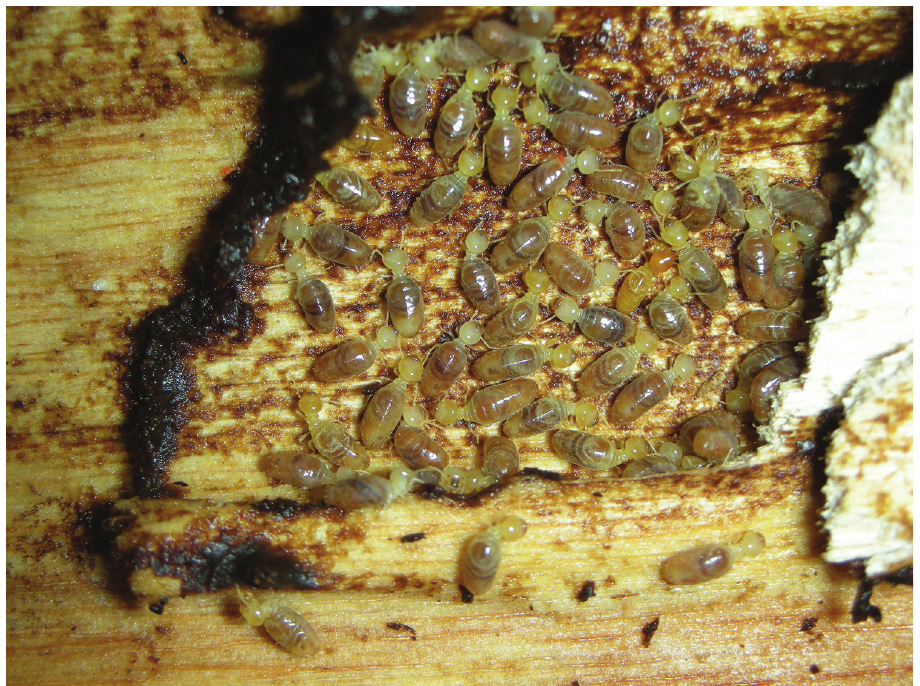
Figure 8. Field photograph of P. mesoamericanus sp. n. foragers feeding within a crevice of damp wood (Coyolito, Honduras; paratype locality,